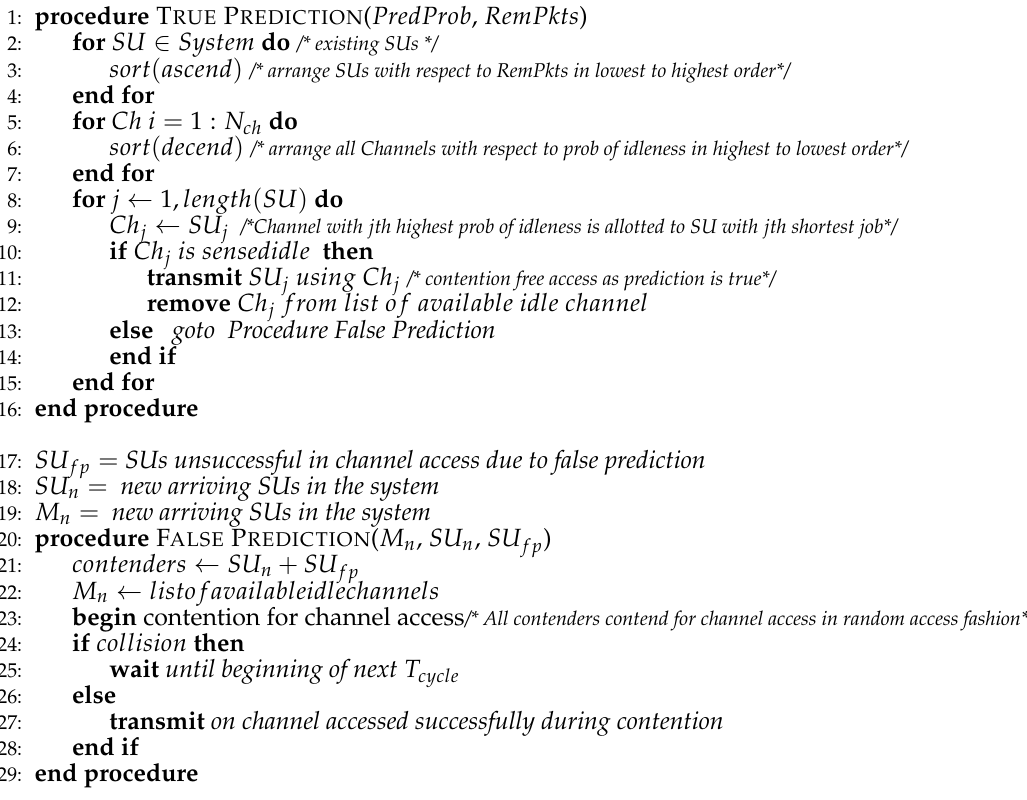
Algorithm 1 Target channel